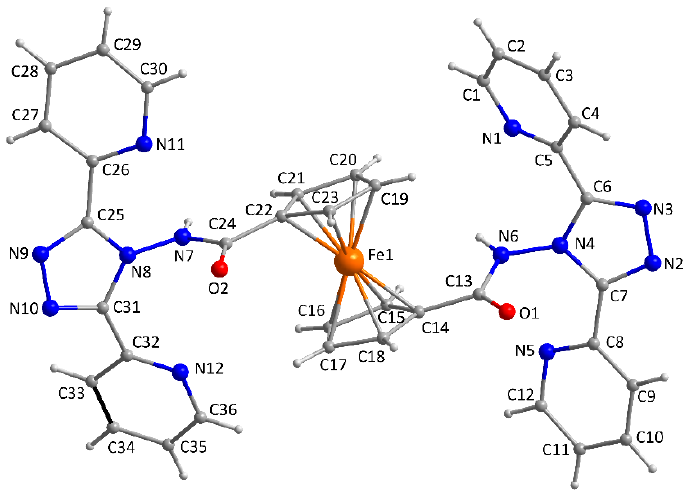
Figure 2. The molecular structure of the studied metalloligand L with atom-numbering of non-hydrogen atoms.